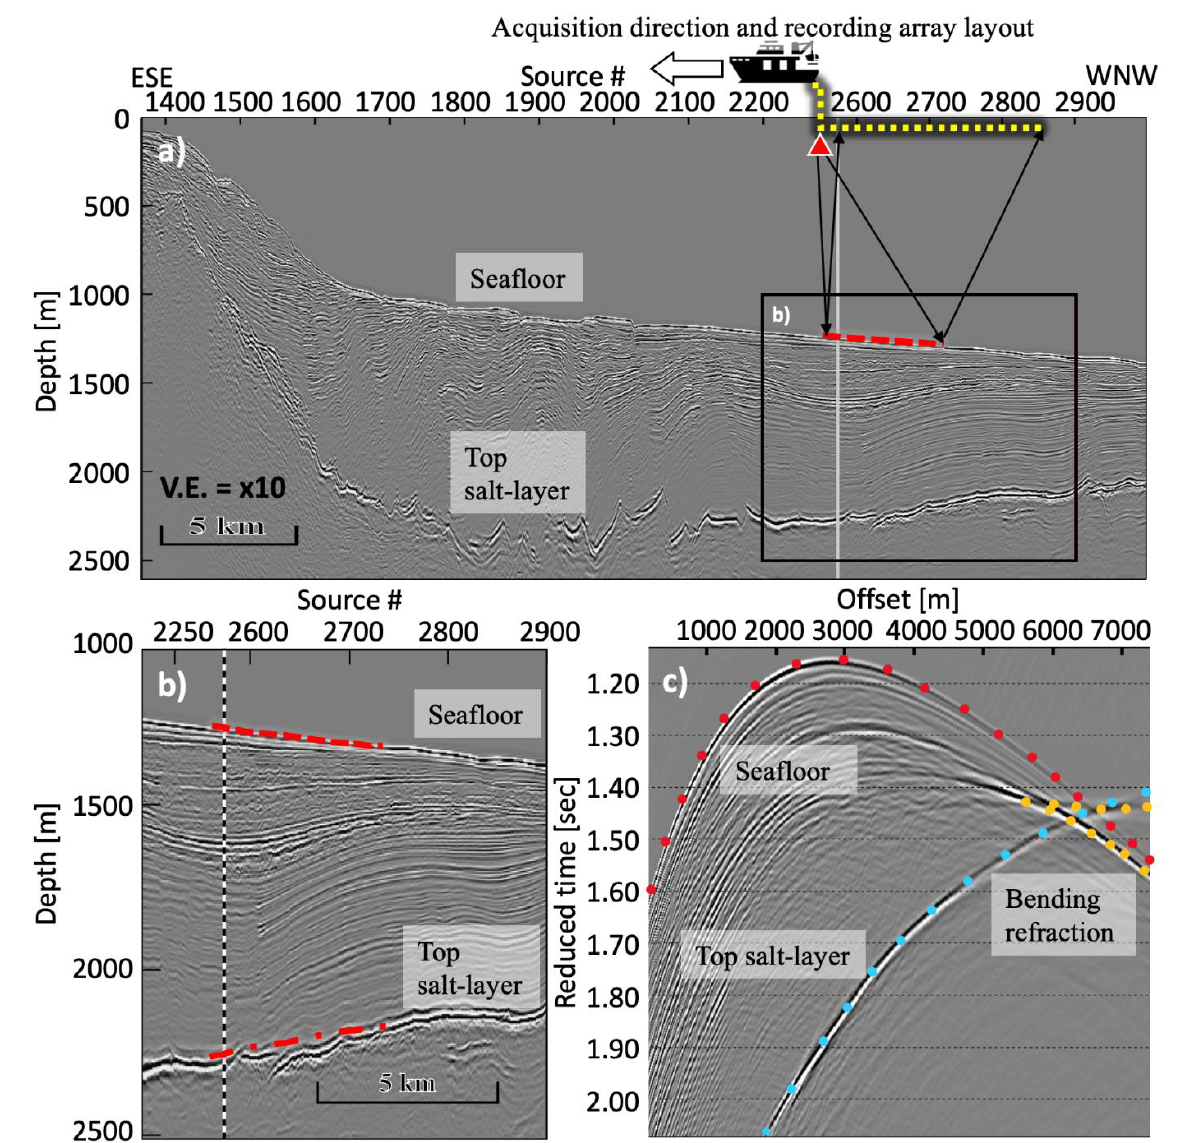
Figure 4. ( a ) A depth-migrated section of TGS line ISEM-2073-108 and ISEM-2073-109, showing the seafloor to salt layer structure from the continental shelf to the studied area, and the geometrical configuration of the experiment. A yellow dashed line depicts the Horizontal Line Array (HLA) of 576 hydrophones used in the experiment. The position of sound source #2290 is depicted by a red triangle. The stretch of the bottom, which was insonified through the recording of source #2290 by the HLA (their footprint), is highlighted with a red dashed line. ( b ) A zoomed section of the area of the studied source #2290. Red dashed and dash-dot lines approximate the reflection footprint stretch of this source for the seafloor and the top salt, respectively. ( c ) A reduced time vs. offset display for source #2290, overlaid with the chosen seafloor reflection (red), top salt reflection (blue), and sub-bottom layer refraction (orange). The reduction velocity is 2000 m s − 1 .